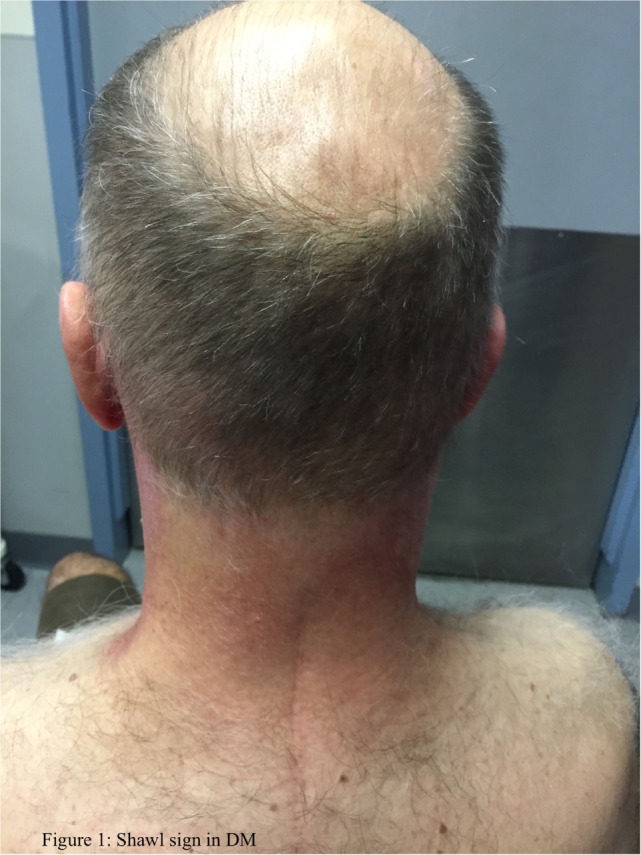
Shawl sign in DM.